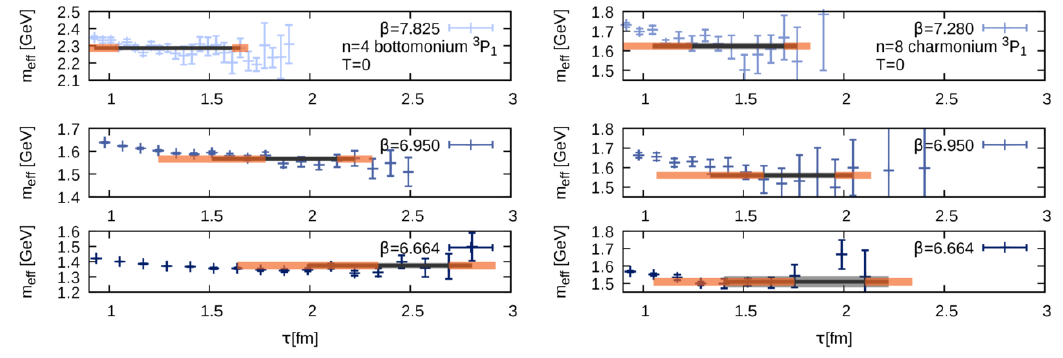
Figure 5 . Selected zero temperature e(cid:11)ective masses of the P-wave channel with bottomonium results on the left and charmonium on the right. We also show the average (cid:12)t interval (black solid) and its variation